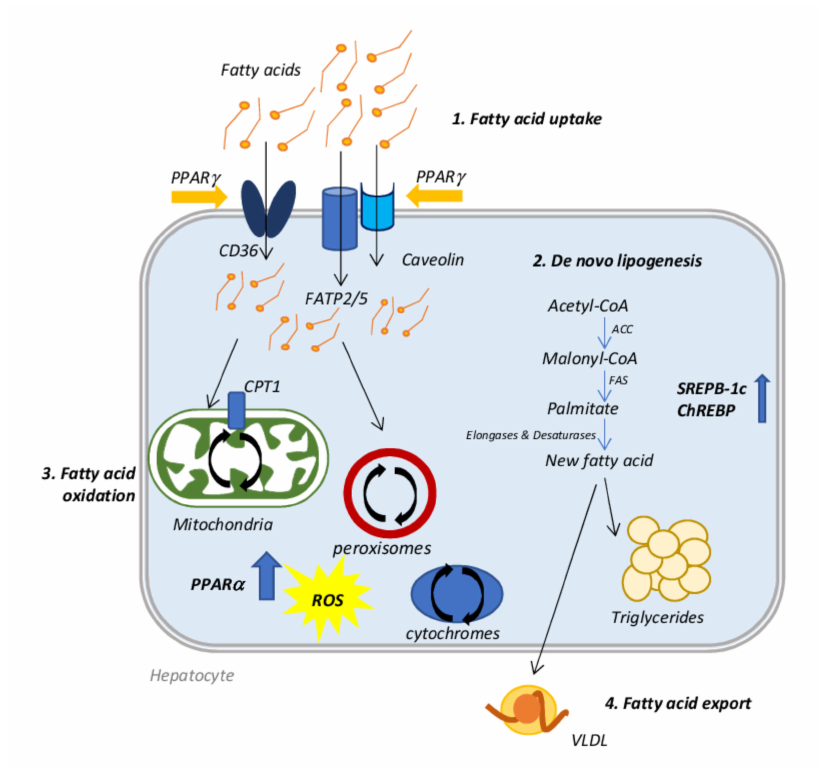
Figure 1. Schematic representation of the molecular mechanisms involved in NAFLD onset. 1. Fatty acid uptake: fatty acids are introduced in the cell by specific transporters such as CD36, FATP2/5 and caveolins, which are controlled by PPAR γ transcriptional activity. 2. De novo lipogenesis: the liver synthesizes fatty acids starting from acetyl CoA. This mechanism is controlled by ChREBP and SREBP-1c activity. The new fatty acid can be stored as triglycerides or exported via VLDL formation. 3. Fatty acid export: VLDL particles are produced by lipidation of apoB100 in the ER and then they are transferred to the Golgi apparatus for a second lipidation that is necessary for maturation and export. 4. Fatty acid oxidation: Fatty acids introduced from the external environment or produced by de novo lipogenesis can be oxidized to form energy by mitochondrial and peroxisomal β -oxidation and by cytochrome ω -oxidation. All these processes produce ROS.